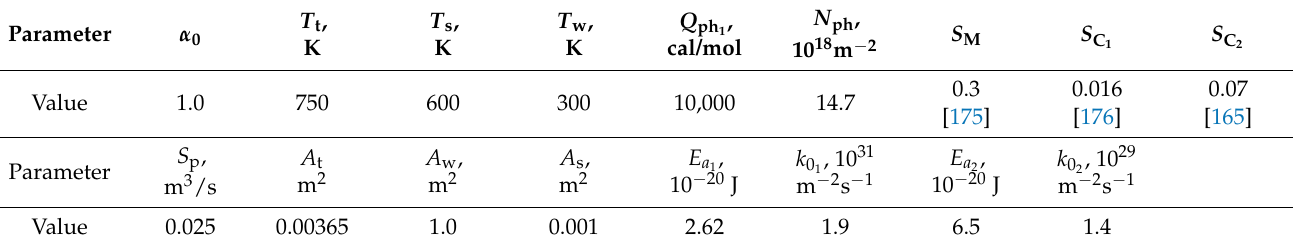
Table 2. Parameters of the reactive sputtering process of a cold titanium target in Ar + O 2 + N 2 .